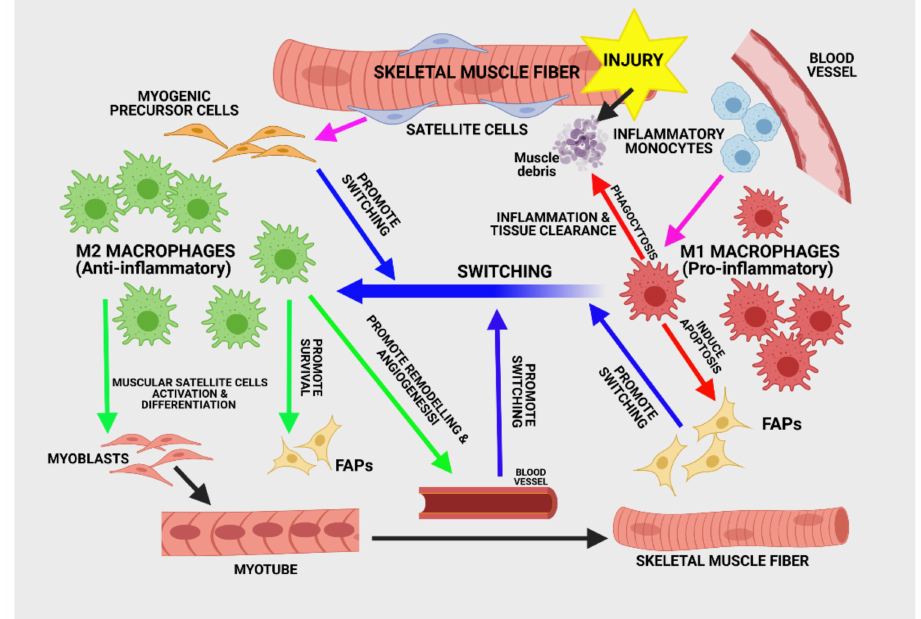
Figure 4. Skeletal muscle regeneration in acute muscle injury. Macrophages play a central role in both the inflammatory process and tissue remodeling. The inflammatory phase after injury is characterized by pro-inflammatory M1 macrophage accumulation, for tissue debris phagocytosis and myogenesis, by promoting satellite cell proliferation, regulating fibrosis by apoptosis of fibro-adipogenic progeni- tors (FAPs). After macrophages switch towards the anti-inflammatory M2 phenotype satellite cells are stimulated to generate myoblasts, myotubes, and myofibers. M2 macrophages also promote an- giogenesis and FAPs survival. The M2 macrophage polarization is supported by myogenic precursor cells, endothelial cells, and FAPs. Created with BioRender.com (accessed on: 7 March 2021). Multiple resident MC cell populations [132,133] and fibro-adipogenic precursor cells [134,135] were reported to support muscle stem/progenitor cell activation, and